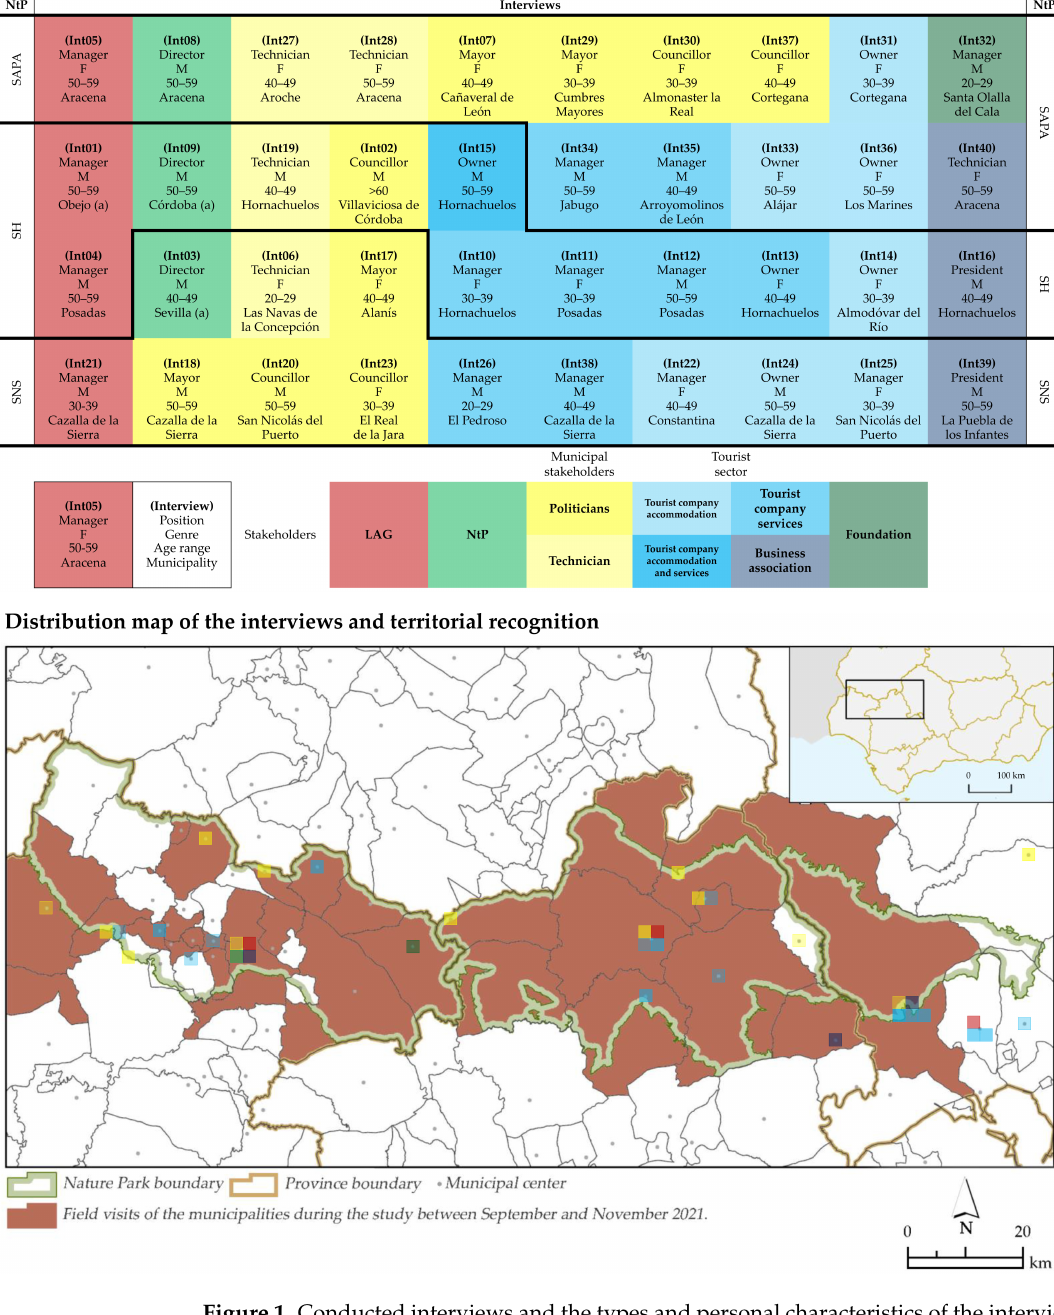
Figure 1. Conducted interviews and the types and personal characteristics of the interviewees accord- ing to the natural parks that they represent. In addition, a map presents the territorial distribution of the interviews carried out and the territorial recognition. Source: authors’ elaboration.